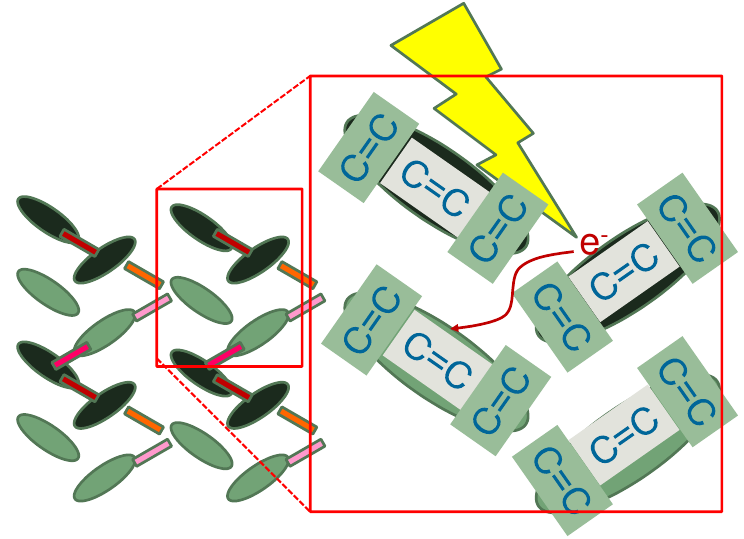
Figure 7. Schematic electronic and molecular structures of (BEDT-TTF) to early-stage photoexcited